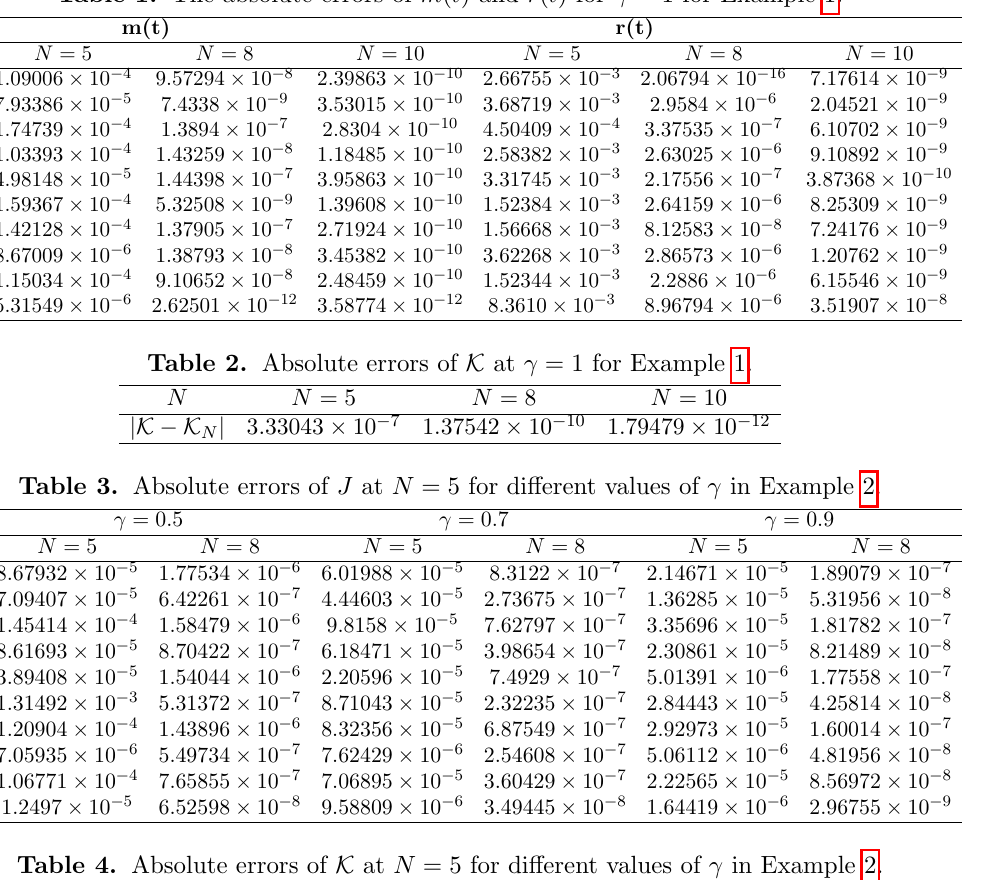
Table 4. Absolute errors of K at N = 5 for different values of γ in Example 2.